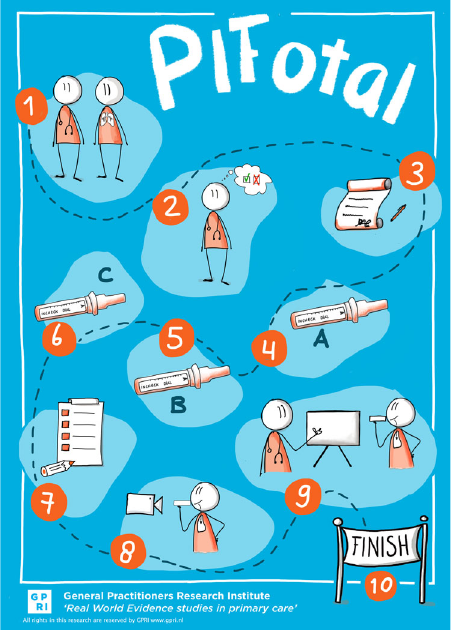
Fig. 1 Flow chart of PIFotal COPD study. Participants were invited for clinical examination (Step 1) and eligibility was veri fi ed (Step 2). Prior to participation, participants provided written informed consent (Step 3). Subsequently, their PIF was assessed, namely typical PIF (Step 4), a patient ’ s maximal PIF against the resistance of their own device (Step 5) and a patient ’ s maximal PIF at low resistance (Step 6). Next, participants fi lled out questionnaires to assess health status, number of exacerbations, self-reported medication adherence, medication use, and demographic and clinical covariates (Step 7). Subsequently, participants inhaled their usual medication, which was video recorded for later assessment (Step 8). Lastly, participants received tailored inhalation